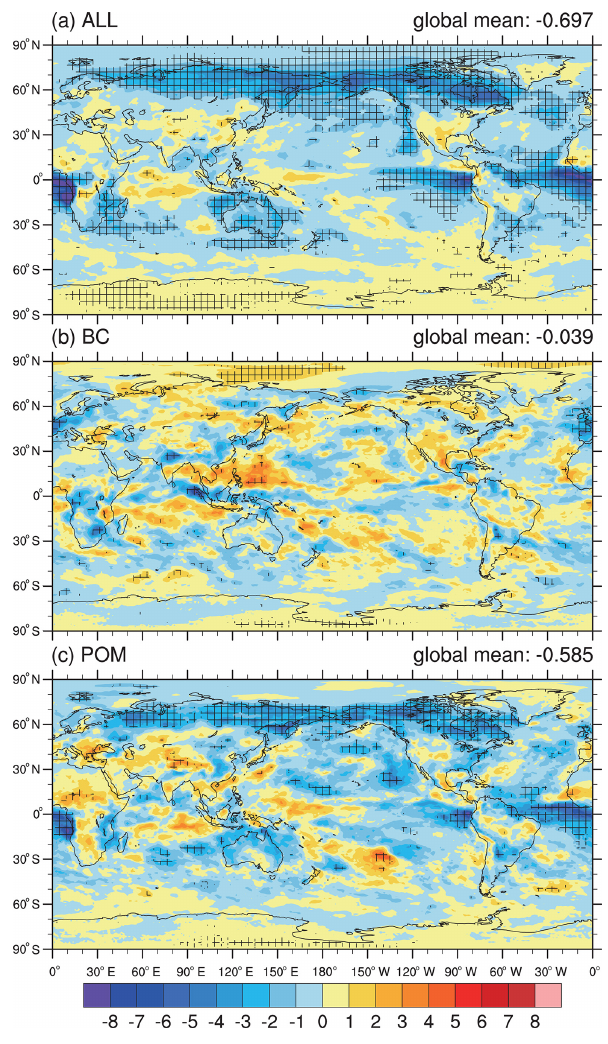
Figure 6. Annual mean radiative effects due to aerosol–cloud inter- actions (REaci) (Wm − 2 ) averaged over the period of 2003–2011 due to (a) all fire aerosols, (b) fire BC and (c) fire POM. The plus signs denote the regions where the radiative effect is statistically significant at the 0.1